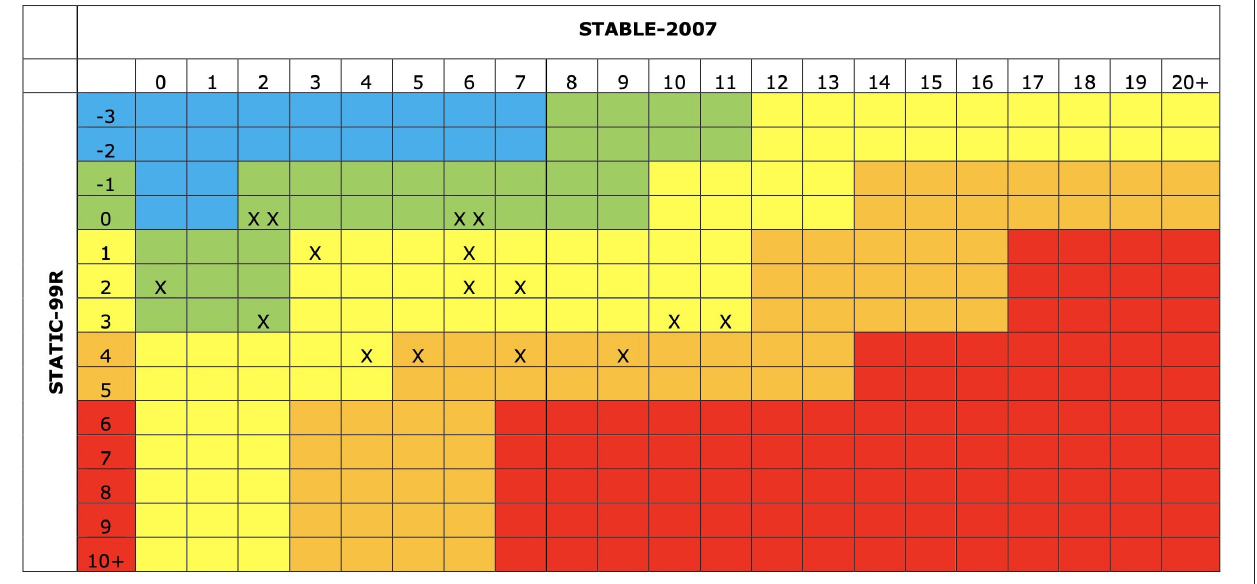
FIGURE 1 | Combined risk categories. Blue: Risk level I, very low risk, which is similar to people with non-sexual criminal histories; Green: Risk level II, below average risk, which is higher than very low (I) risk profile but lower than average (III); Yellow: Risk level III, average risk level; Orange: Risk level IVa, above average risk, which is approximately two times the average risk (III); and Red: Risk level IVb, well above average risk, which is approximately three to four times the average risk (III) ( Brankley et al., 2017